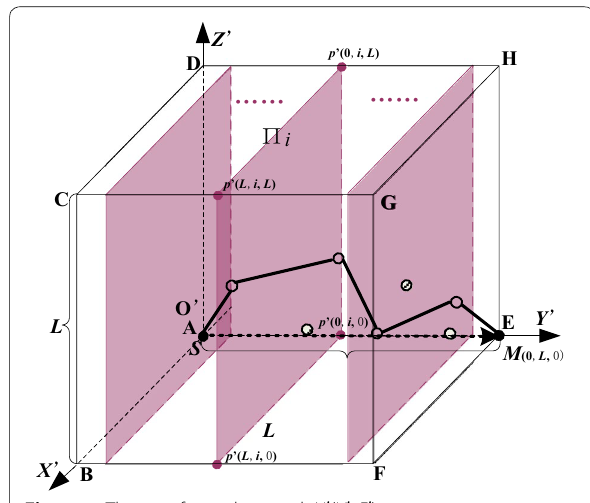
Figure 4 The transformed network N ′ ( V ′ , E ′